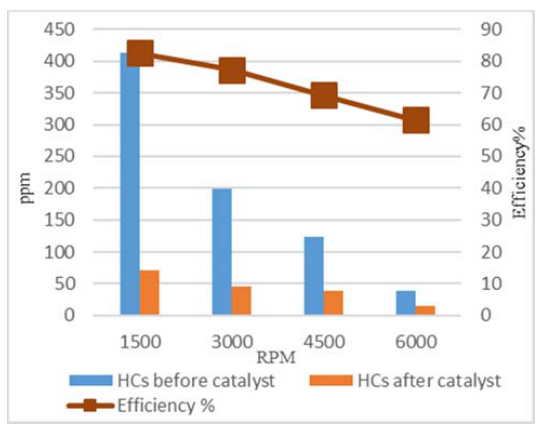
Figure 12. HC Conversions with Co 3 O 4 /TiO 2 .